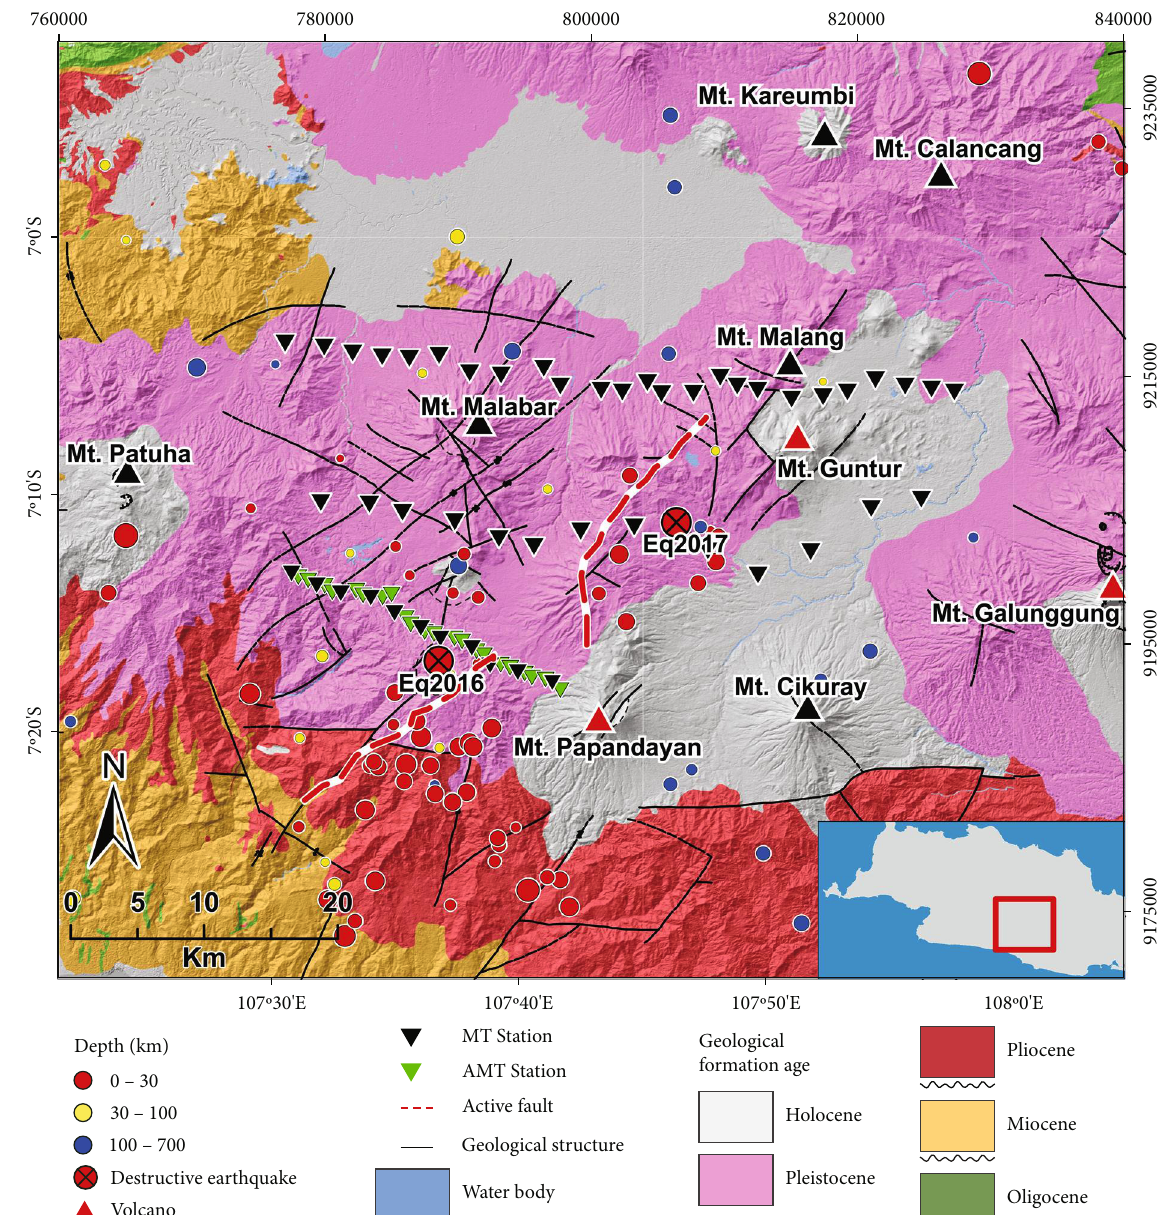
Figure 2: Simpli fi ed geological map of the southern Garut area based on rock formation age (modi fi ed from Arisbaya et al. [13]). The surface geology was from [19, 20], while seismicity was compiled from [1,